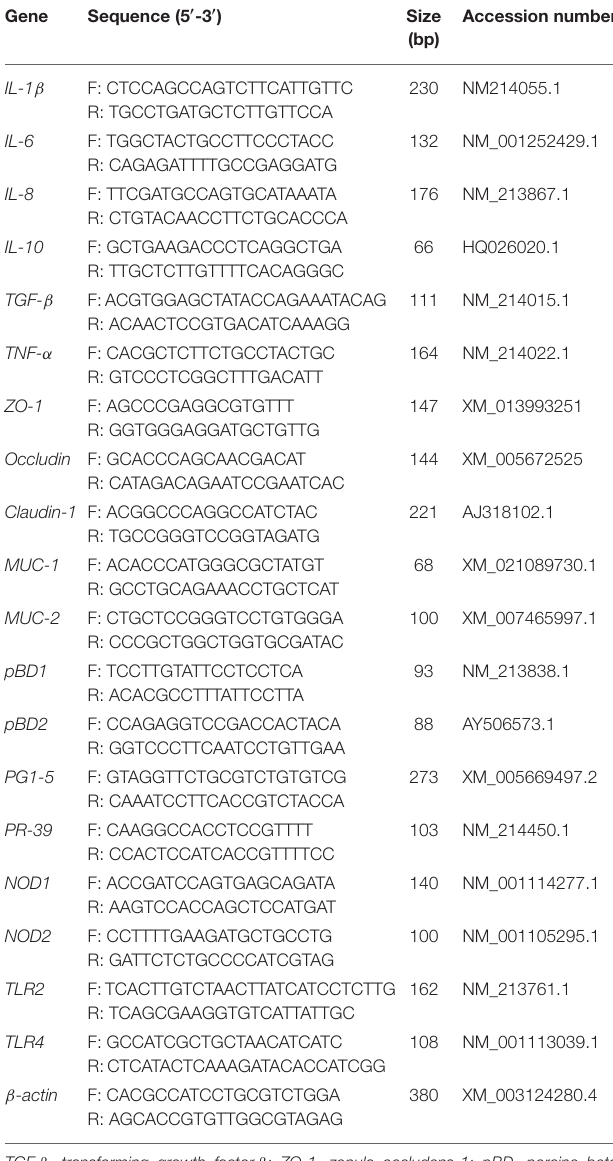
TABLE 3 | Primers for the real-time PCR